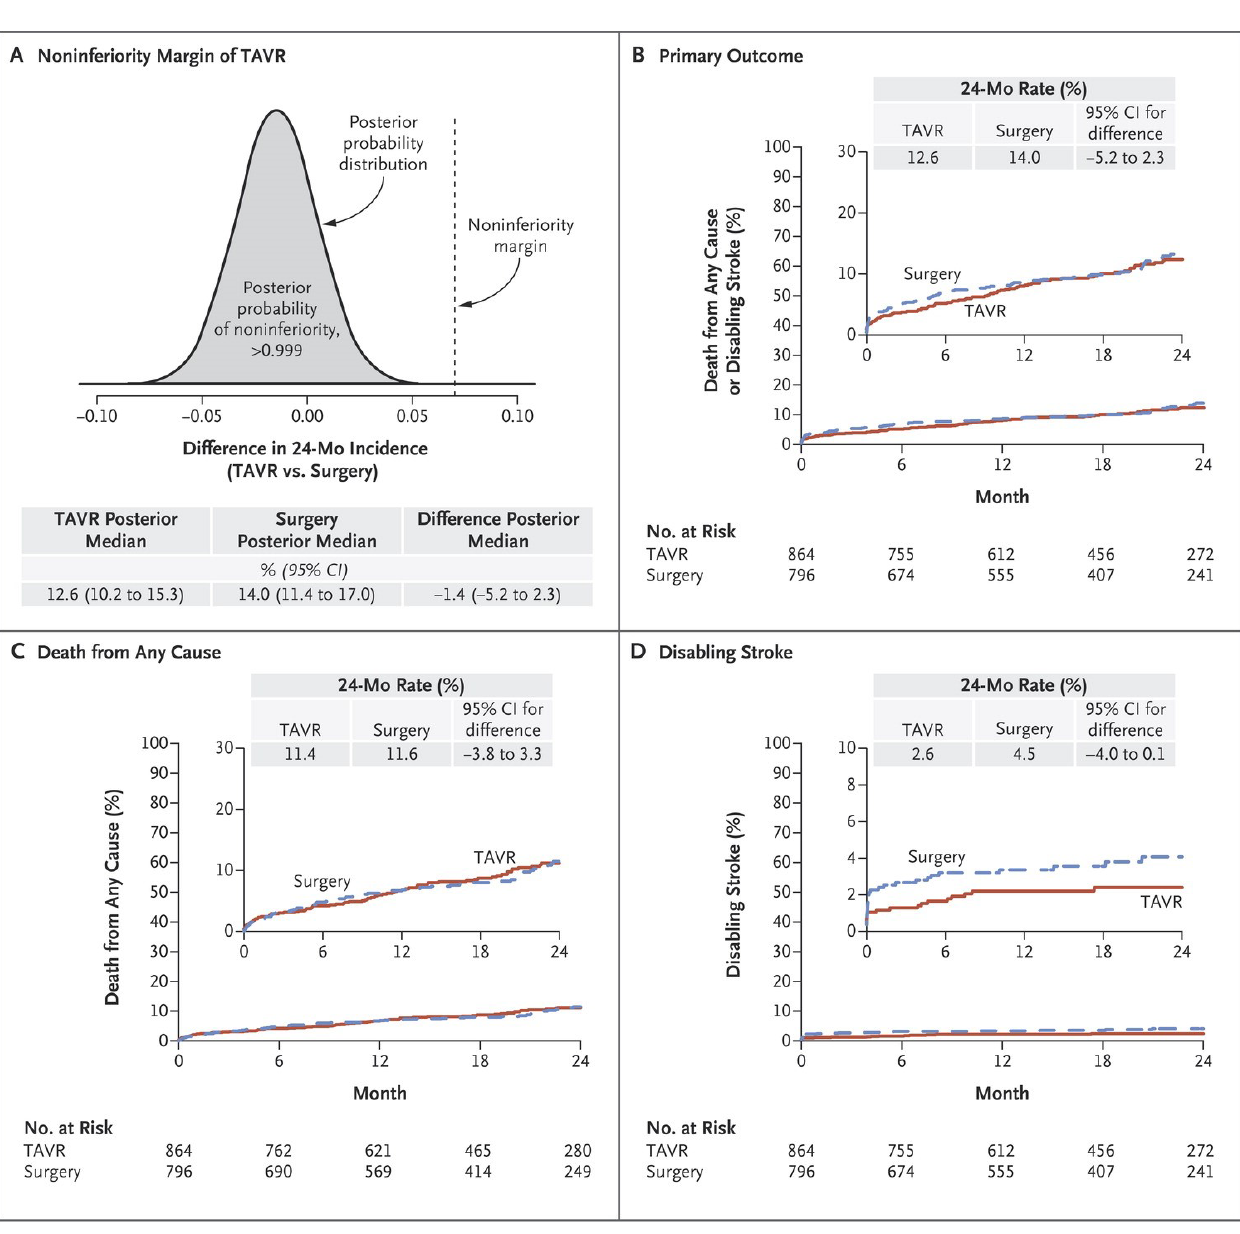
Figure 1. SURTAVI Outcomes. ( a ) Confirmation of the non-inferiority margin for TAVI. ( b ) Time-to-event for death from any cause or disabling stroke. ( c ) Time-to-death from any cause. ( d ) Time-to-disabling stroke. From Reardon et al. , 2017 12 . Reprinted with permission from Massachusetts Medical